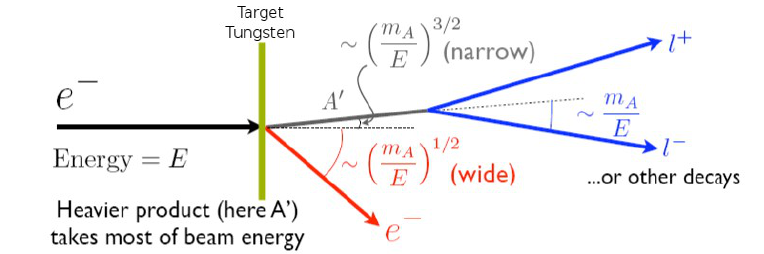
Figure 1. Characteristic production angles for the A’ and its leptonic decay